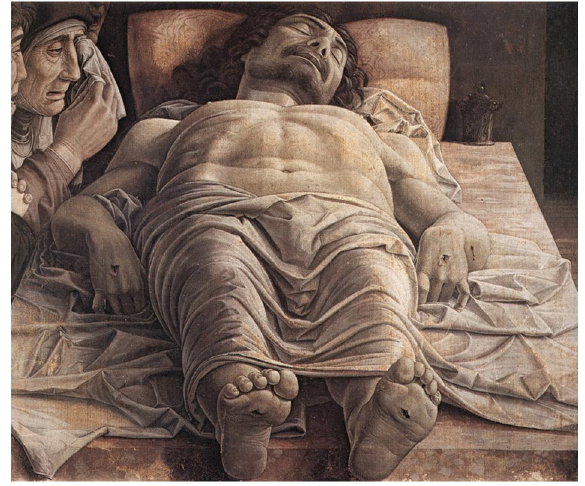
Figure 1. Andrea Mantegna “The Lamentation over the Dead Christ” ( ca . 1480), Pinacoteca de Brera, Milan, Italy (Tempera on canvas, 68 cm × 81 cm).